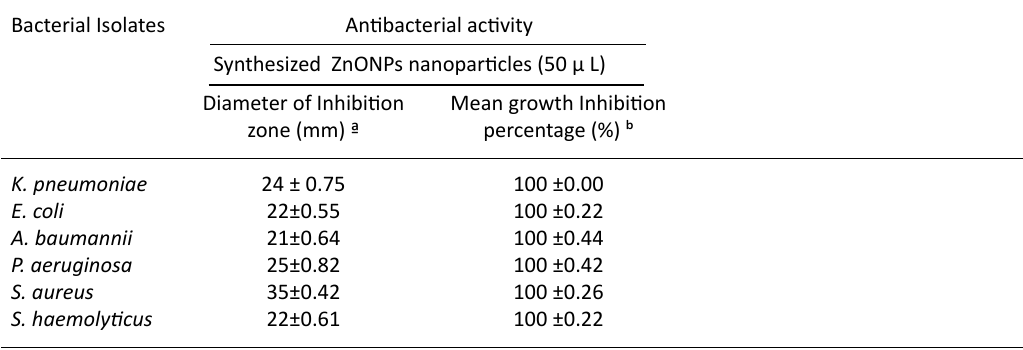
Table 3. The antibacterial activity of prepared ZnO-NPs using agar well diffusion method and broth micro dilution assay. Bacterial Isolates